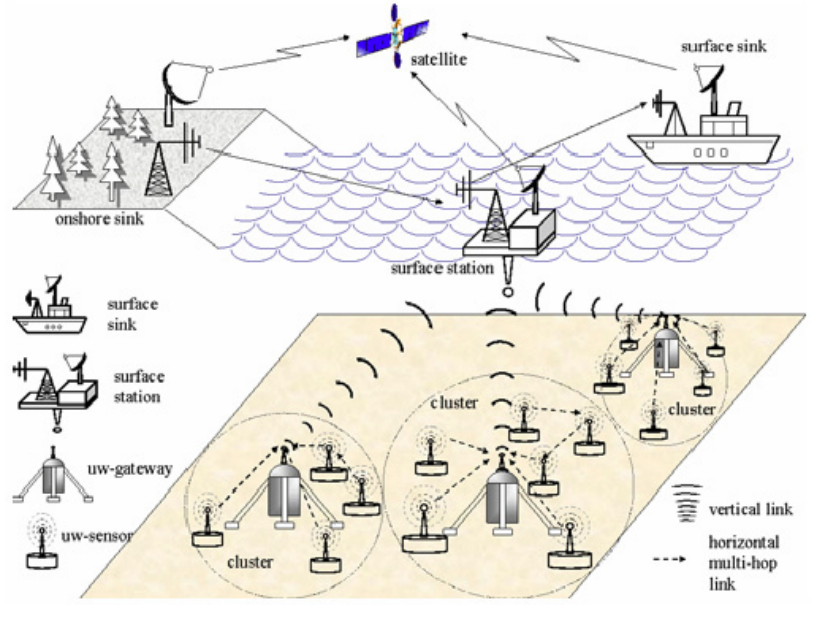
Figure 1. The network model for 2D UWSNs